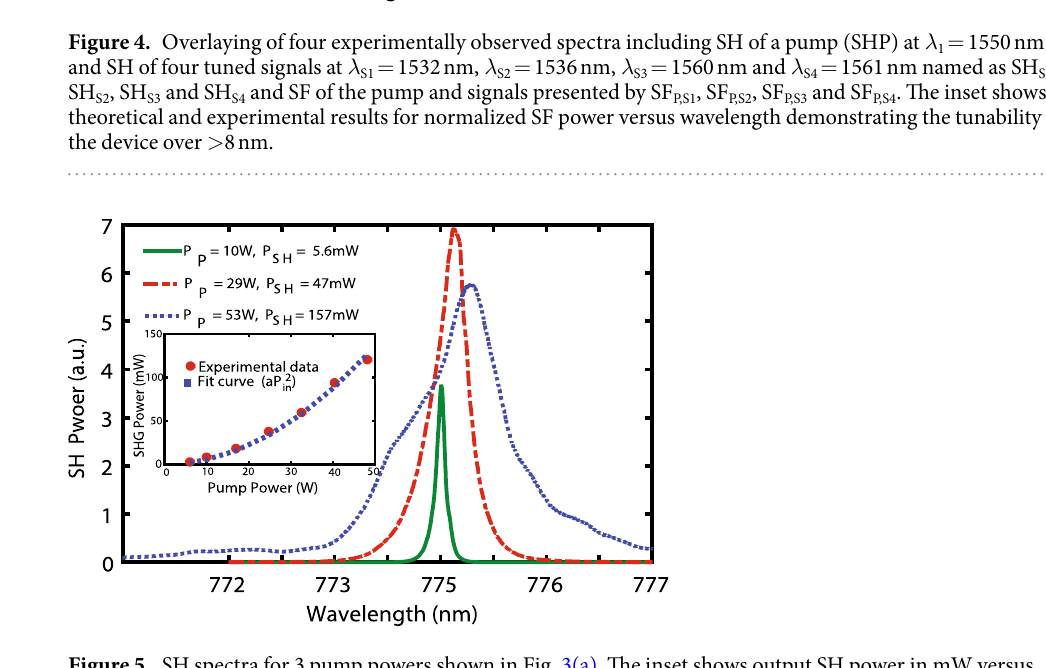
SC-PPLN, shown in Fig. (2). The simulated and experimental results (at 25 °C) for normalized maximum SF power versus wavelength is plotted in the inset of Fig. 4 for a pump at 1550 nm and a swept control signal. The measured SF central wave- length is successively tuned from ~770 nm to 778 nm by tuning the control signal from 1530 nm to 1560 nm, confirming an experimentally tunable BW of ~8 nm for the SF whilst for an equivalent-length, uniform PPLN, it is only 0.41 nm, demonstrating the super-tunability of our SC-PPLN. However, the difference between experi- mental and simulated results comes from accumulated phase differences in the fabrication and errors involved in the poling process. The simulated response in the inset is shown in a wider range than the experimental one as the SC-PPLN is designed to work also at higher temperatures. Theoretical calculation for the SF power using Eq. 1 and assuming Gaussian functions (approximately) with the integrated powers and bandwidths of ( P 1 , σ 1 ) and ( P 2 , σ 2 ) for the pump and signal, respectively leads to